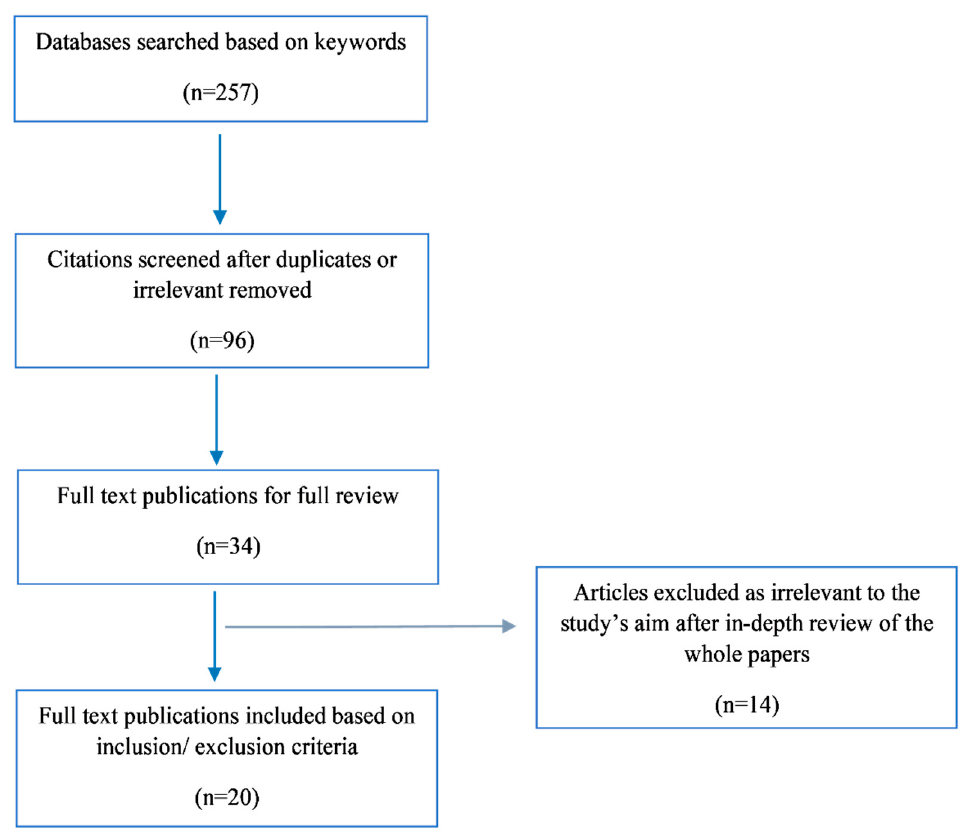
Figure 1. Flowchart on the literature selection process based on guidelines by Ferrari (2015).